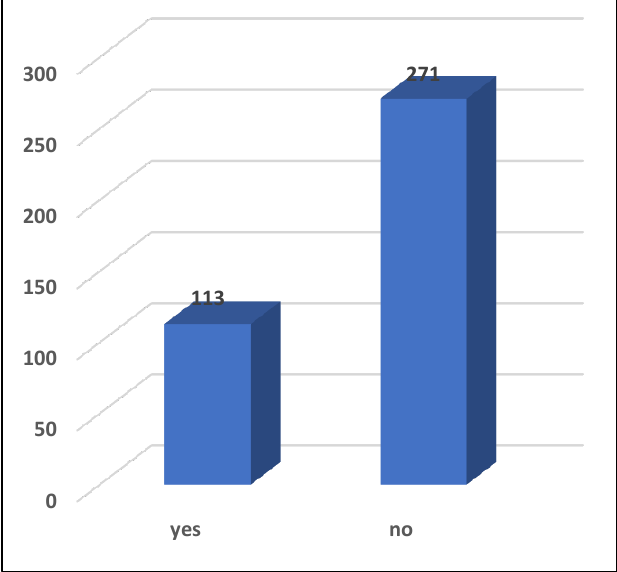
Fig. 9. Willing to pay for waste